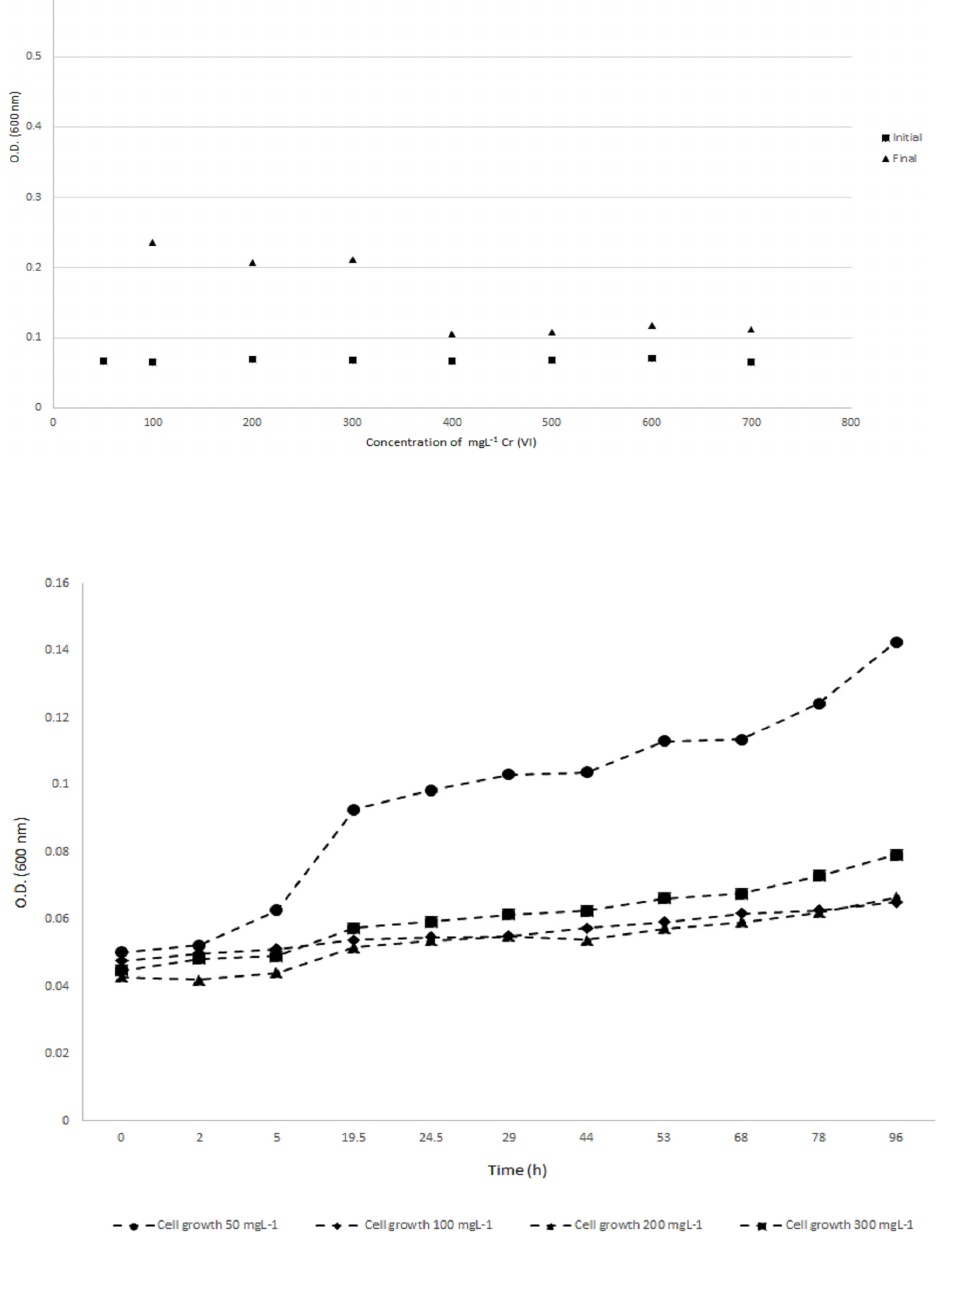
Figure 1. Resistance of the strain 2(1B)104A to different concentrations of Cr after 48 h of growth.